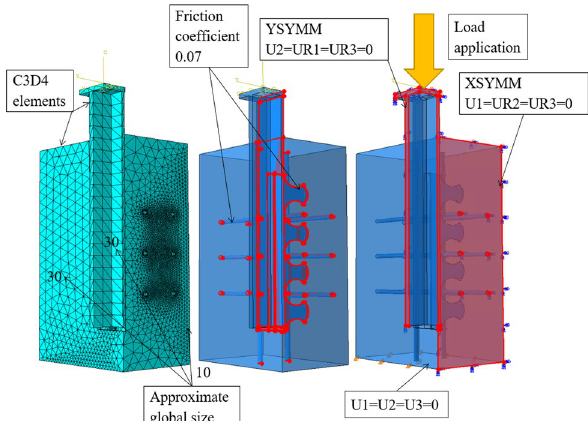
Figure 9. ABAQUS software specifications of mesh, interaction and loading and boundary conditions